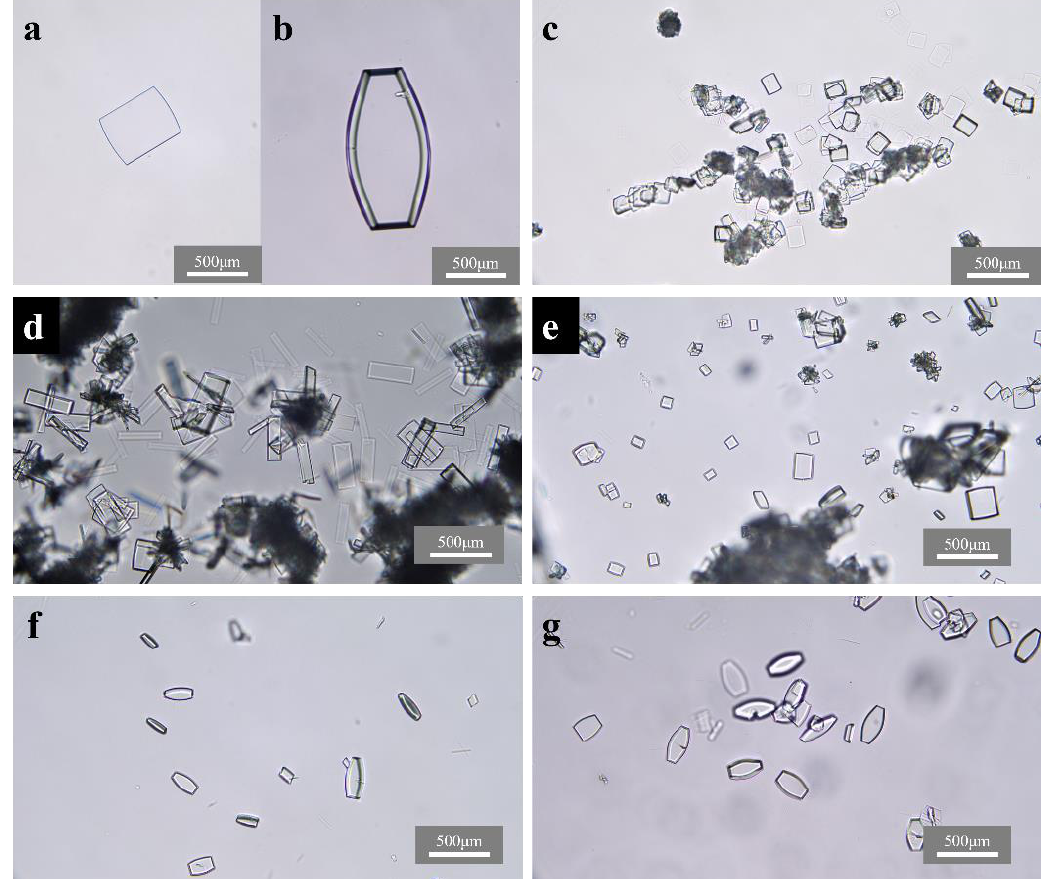
Figure 3. ( a ) Pyriproxyfen crystal with lamellar shape in ethanol; ( b ) pyriproxyfen crystal with shuttle shape in heptane; pyriproxyfen crystal grown in ( c ) methanol, ( d ) ethanol, ( e ) N-propanol, ( f ) N-butanol, and ( g ) heptane.